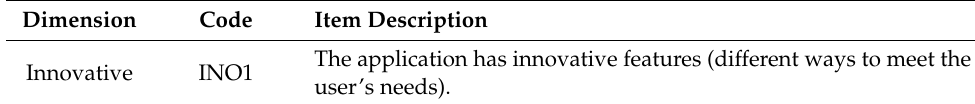
Table 4. The Innovative dimension and its